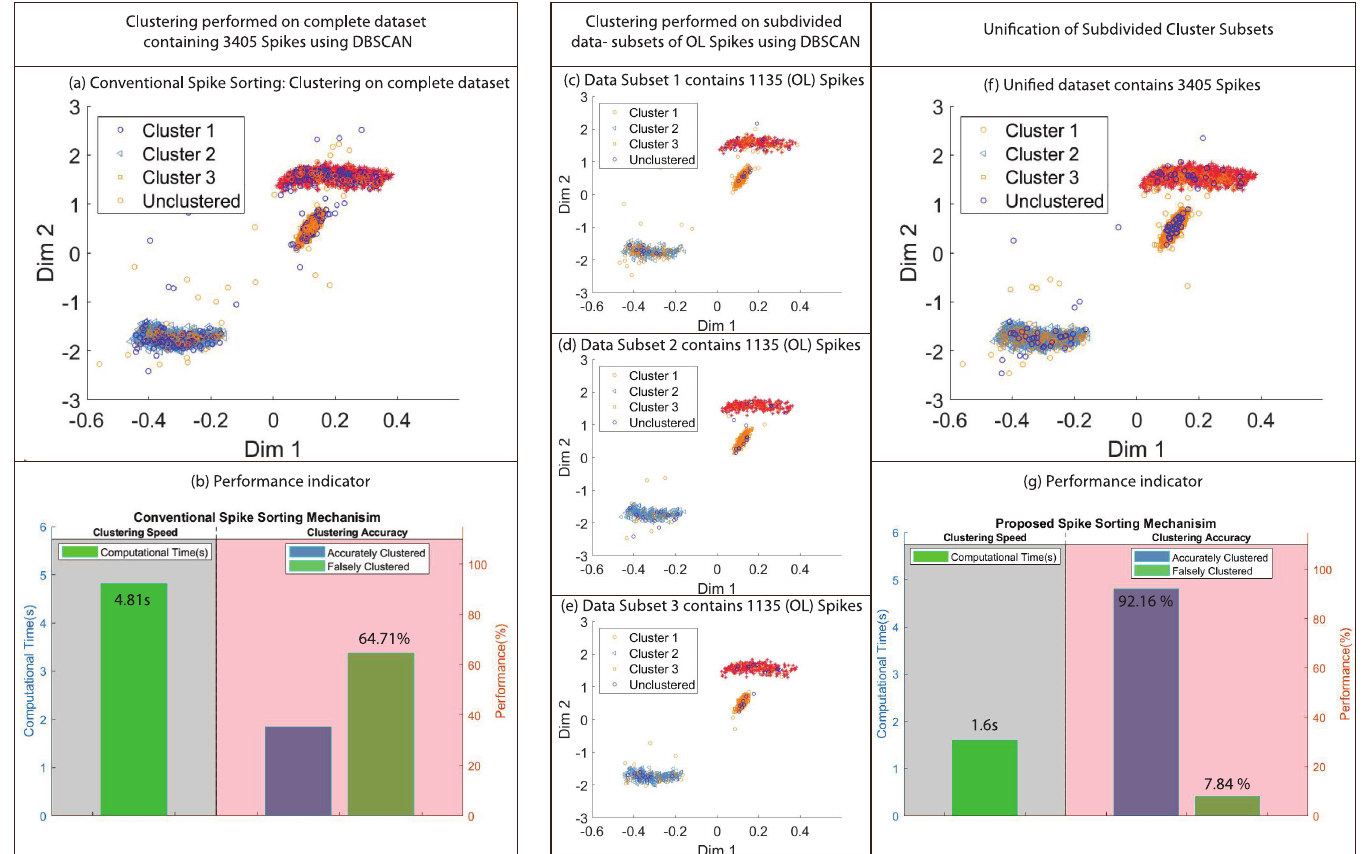
Fig 9. Comparison of clustering results obtained using conventional and proposed mechanism employing DBSCAN with dataset 1 and Wavelet features. (a) Clustering results using conventional spike sorting method applied on complete dataset containing 3405 Spikes. (b) Performance indication of clustering results based on computational time/speed and clustering accuracy. (c)-(f) Clustering results using proposed spike sorting mechanism applied on data-subdivision of optimal length i.e 1135 for DBSCAN. (g) Unification of subdivided cluster subsets. (h) Performance indication of clustering results using proposed spike sorting method.